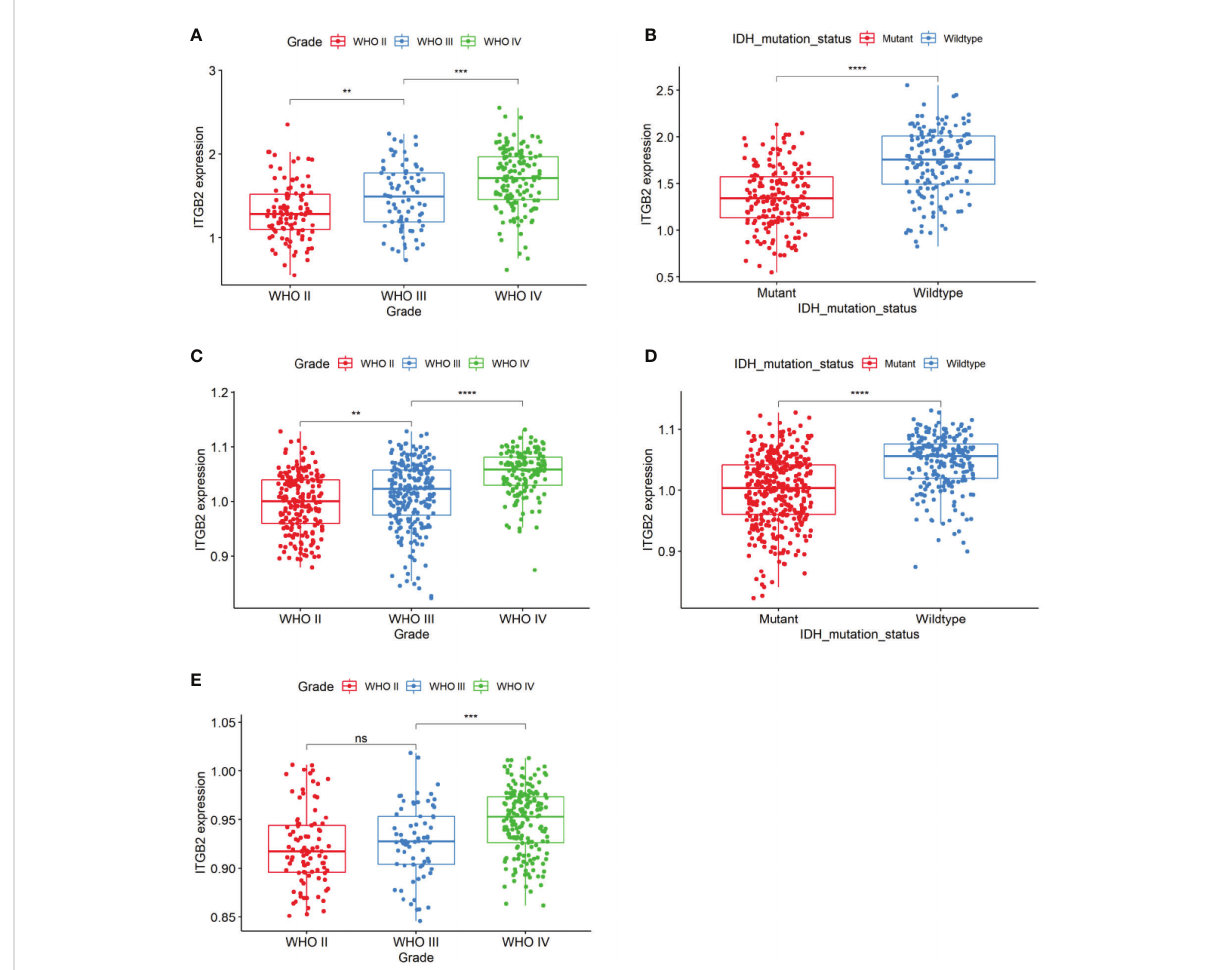
FIGURE 1 ITGB2 mRNA expression pattern in CGGA RNA-seq, TCGA-GBMLGG RNA-seq, and Rembrandt microarray datasets. (A) ITGB2 is enriched in high-grade gliomas in CGGA RNA-seq sets. (B) ITGB2 is enriched in IDH1 wt gliomas in CGGA RNA-seq sets. (C, E) ITGB2 is enriched in high-